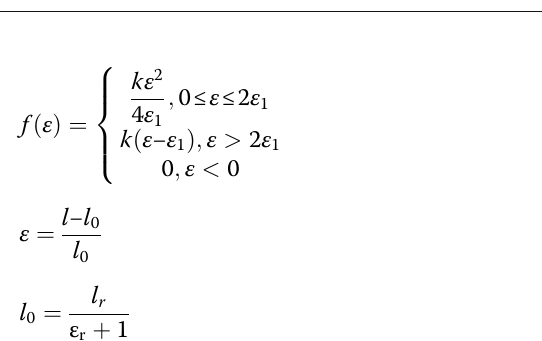
Fig. 1 3D FE knee joint model developed from imaging data used in this